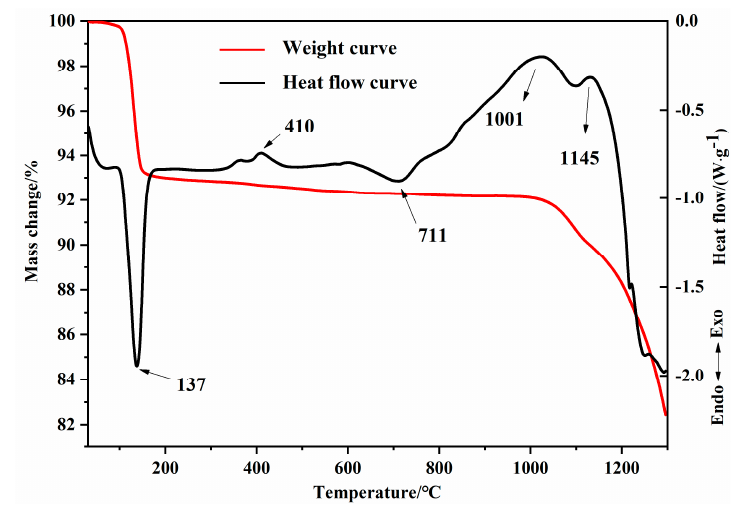
Figure 4. TG － DSC curve of raw materials for C 5 S 2 $ during the heating process.